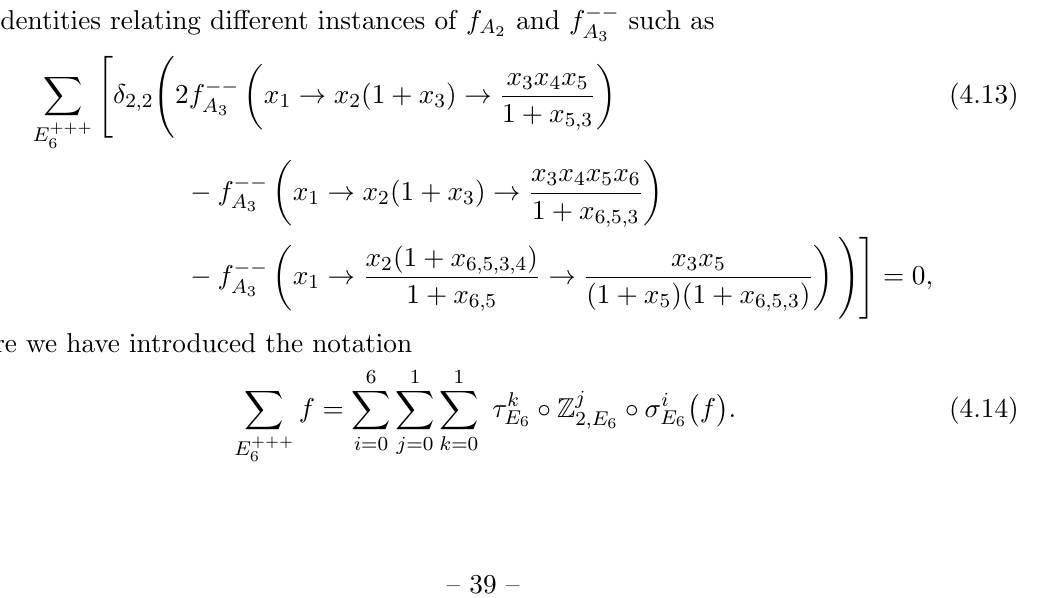
-constructible cluster polylogarithms on the E A 3